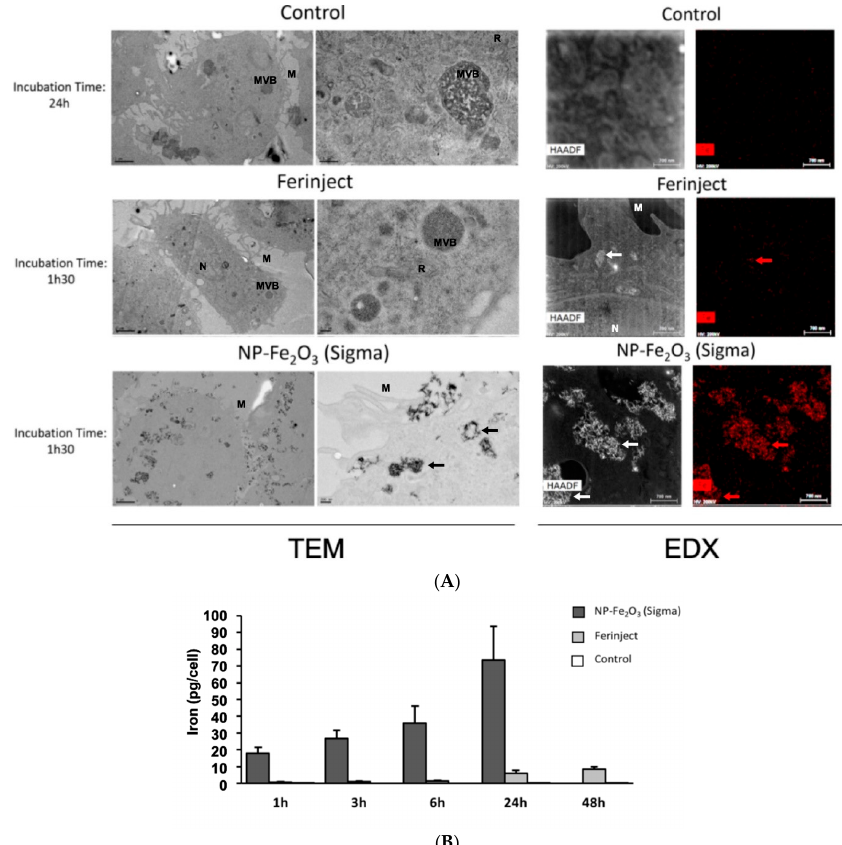
Figure 4. Assessment of Kinetic of iron uptake in J774A.1 cells incubated for various times of incubation with or without FERINJECT ® or Fe 2 O 3 -NP. Pannel ( A ): TEM and HAADF-EDX microscopy. J774A.1 were incubated 1h30 with FERINJECT ® or Fe 2 O 3 -NP (compared with Figure 3B) TEM scale bar, Left column = 2 µ m; Right column = 0.2 µ m. HAADF and EDX microscopy scales bar = 0.7 µ m. N = Nucleus; M = Microvillosity; R = Reticulum; MVB = Multivesicular bodies; arrow = vesicle with iron particles. Pannel ( B ): Quantitative assessment of the Kinetic of iron engulfed by macrophages (1 h to 24 h of incubation with FERINJECT ® or Fe 2 O 3 -NP) using the bathophenanthroline